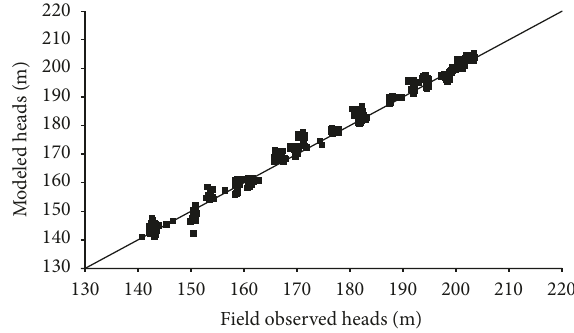
Figure 6: Scattergram of measured versus modeled heads in MODLOW.